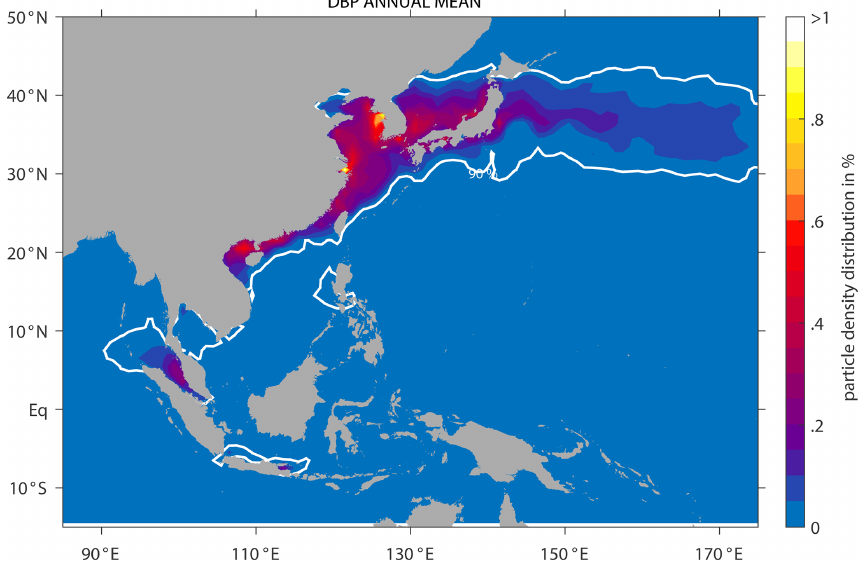
Figure 3. Annual mean particle density distribution in percent (%) of DBPs from cooling-water treatment in coastal power plants in East and Southeast Asia. The white contour line shows the patches where 90% of the largest particle density is